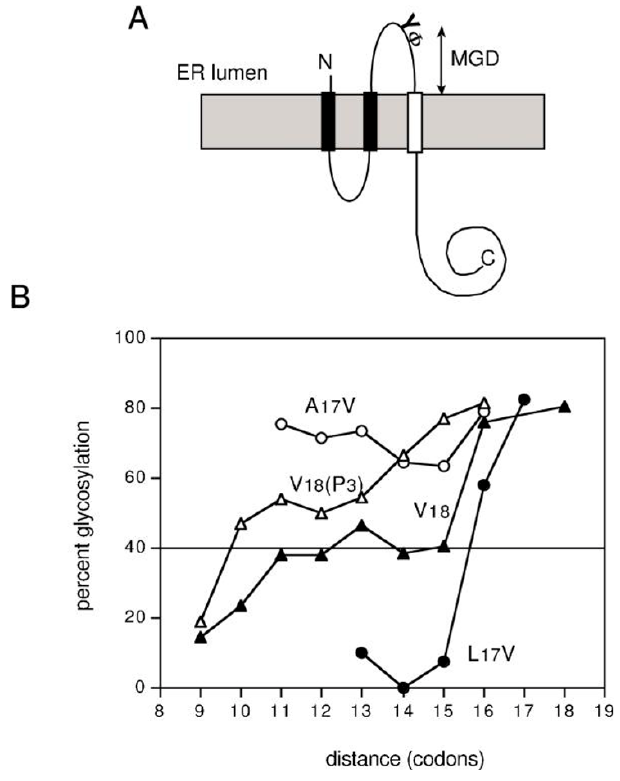
Figure 4 Determination of the "minimal glycosylation distance" (MGD). (A) The MGD is defined as the minimum number of residues required to bridge the distance between the lume- nal end of a transmembrane segment (white) and the active site of oligosaccharyl transferase ( Y denotes a glycosylated site, Φ a non-glycosylated site). (B) MGD measurements for constructs with the indicated model segments. Half-maximal glycosylation (40%) is indicated by the horizontal line. The MGD value is counted from the first polar residue before the transmembrane segment (Gln) up to the acceptor Asn resi- due as in